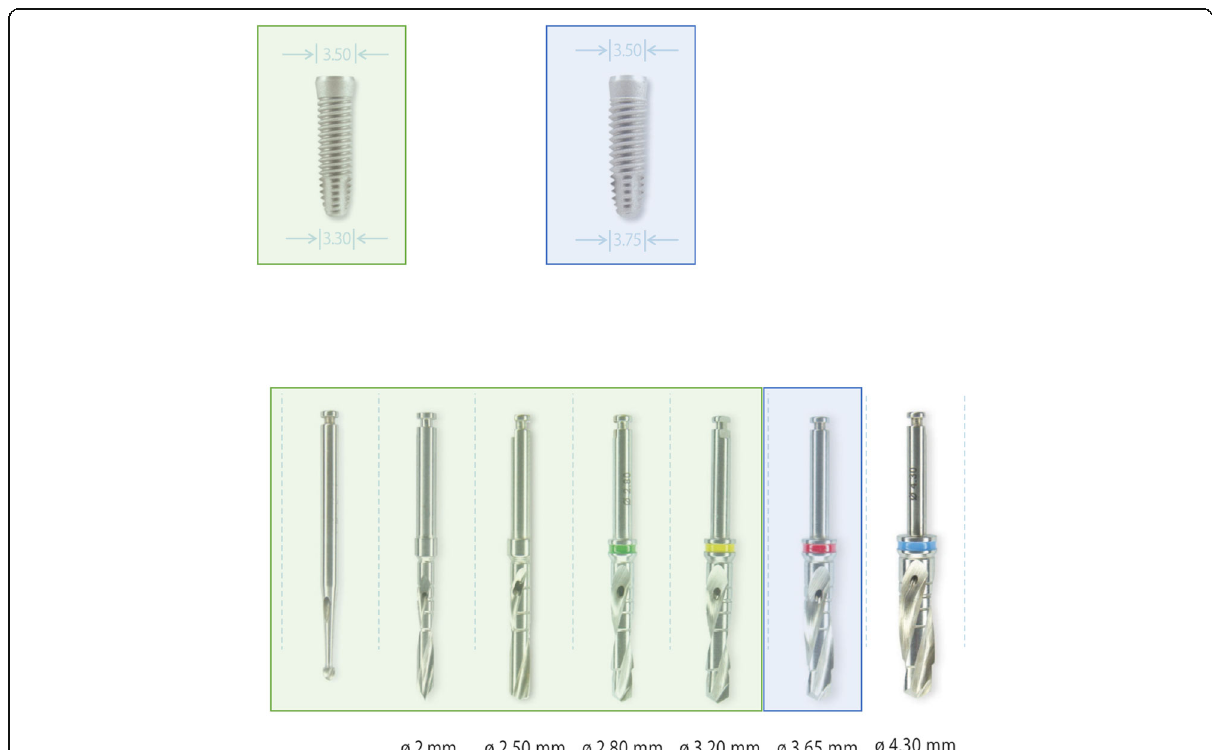
Fig. 2 Over-dimensioned protocol. The over-dimensioned protocol was conducted by a final drill of 1 mm narrower than the implant diameter. The final drill for implants of 3.3. mm was 3.2 mm and of implants measuring 3.75 mm, it was 3.65 mm. Within this study, an over-dimensioned protocol was defined as a final drill larger than recommended by the company, which is in this case 4 or 4.5 mm wider than used in the standard protocol. Permissions for reproducing the figures were received from HI-TEC IMPLANTS LTD. Source: Product Catalogue 12th Edition